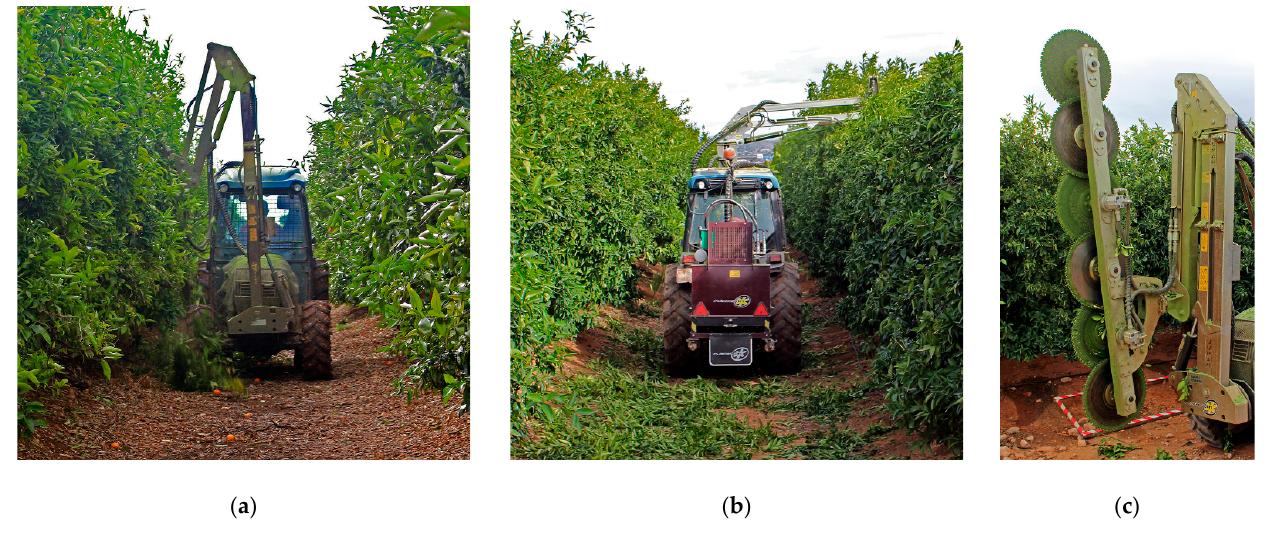
Figure 2. Tractor-mounted pruning machine used in the trials: ( a ) hedging cutting; ( b ) topping cutting; ( c ) articulated arm with six cutting